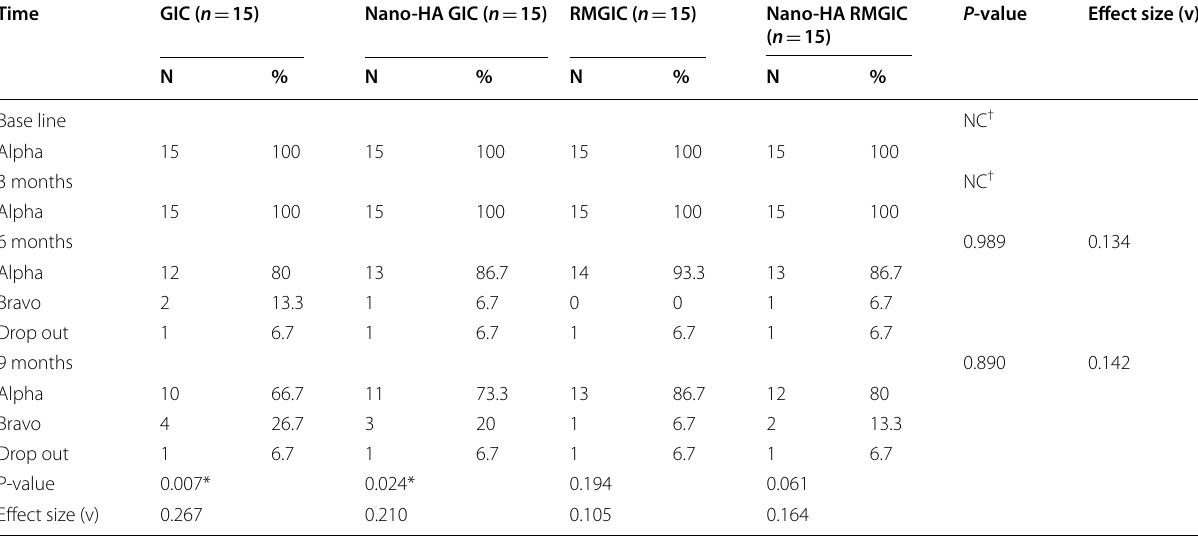
*Significant at P